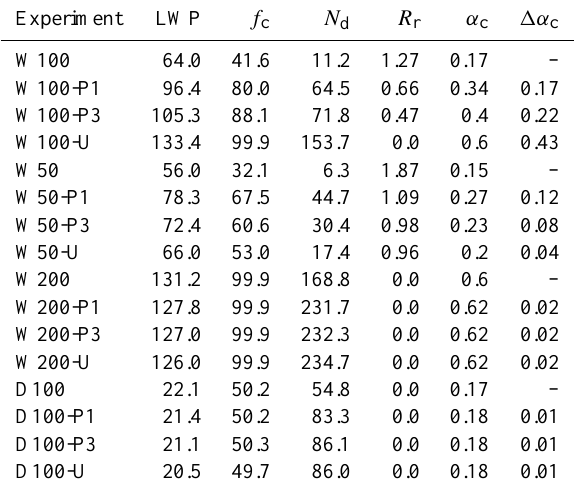
Table 2. Domain- and time-averaged LWP (gm − 2 ) , cloud fraction ( f c , %), drop number concentration ( N d , mg − 1 ) , surface rain rate ( R r , mmd − 1 ) , cloud albedo α c and its change relative to the corre- sponding baseline simulation. Time-average is taken over the last 24h of the